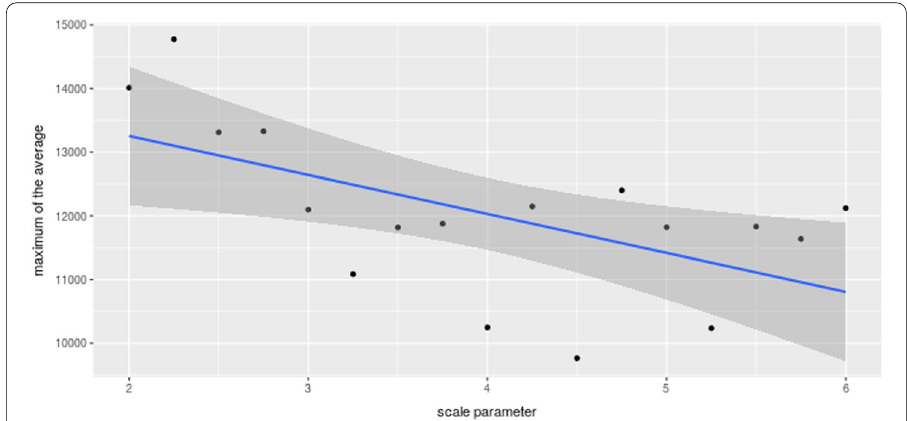
Fig. 7 The maximal value of price time series averaged over 80 simulations is plotted against the parameter α of the Beta distribution controlling the liquidity deeper in the order